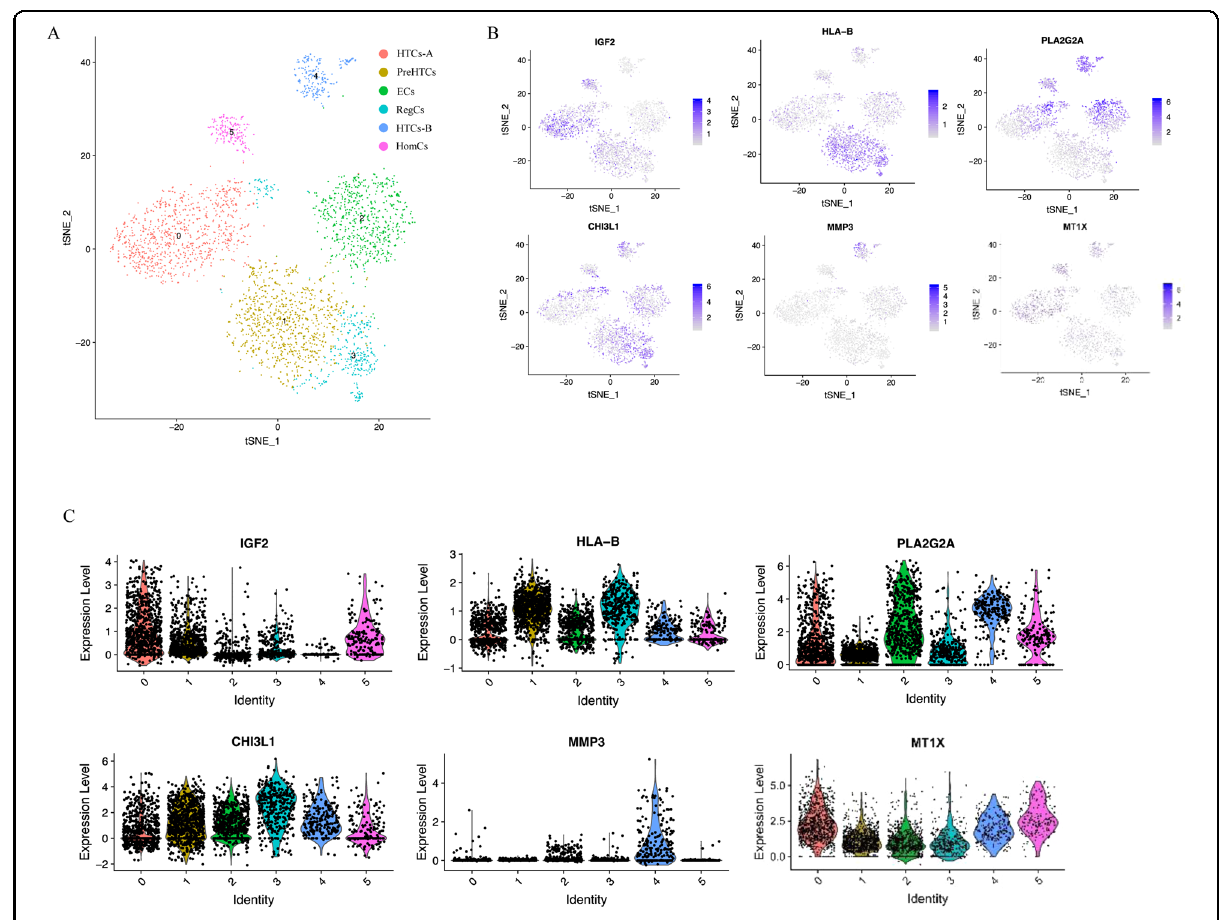
Fig. 5 Recluster analysis of prehypertrophic chondrocytes, hypertrophic chondrocytes, regulatory chondrocytes and effector chondrocytes. A Visualisation of reclustering by t-SNE plot of the original cluster 3 and 4, identi fi ed by cell type. B T-SNE plots demonstrating the gene expression of markers used to identify the cell identity of each cluster. Dot colour corresponds to the level of gene expression in each cell. C Violin plots of gene expression of chondrocyte markers by reclustering original clusters 3 and